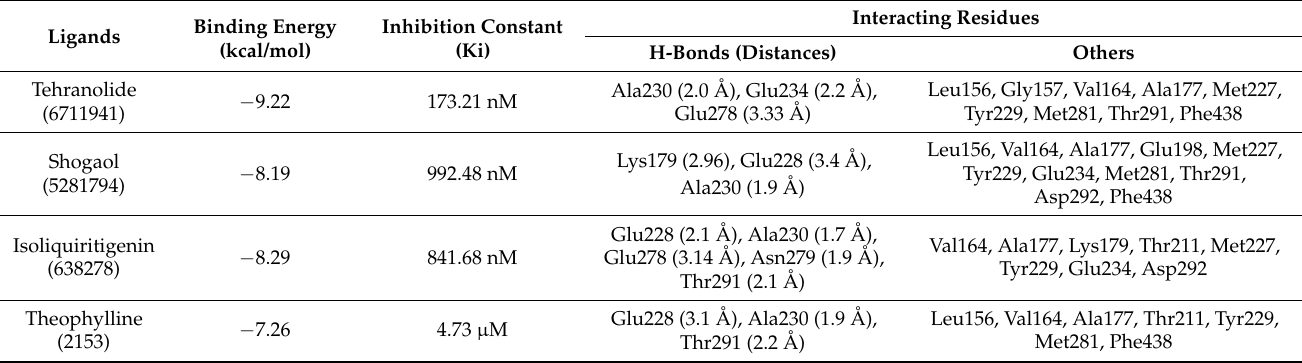
Table 1. Docking results of AutoDock showing binding energy, inhibition constant, and interacting residues for ligands (tehranolide, shogaol, isoliquiritigenin,